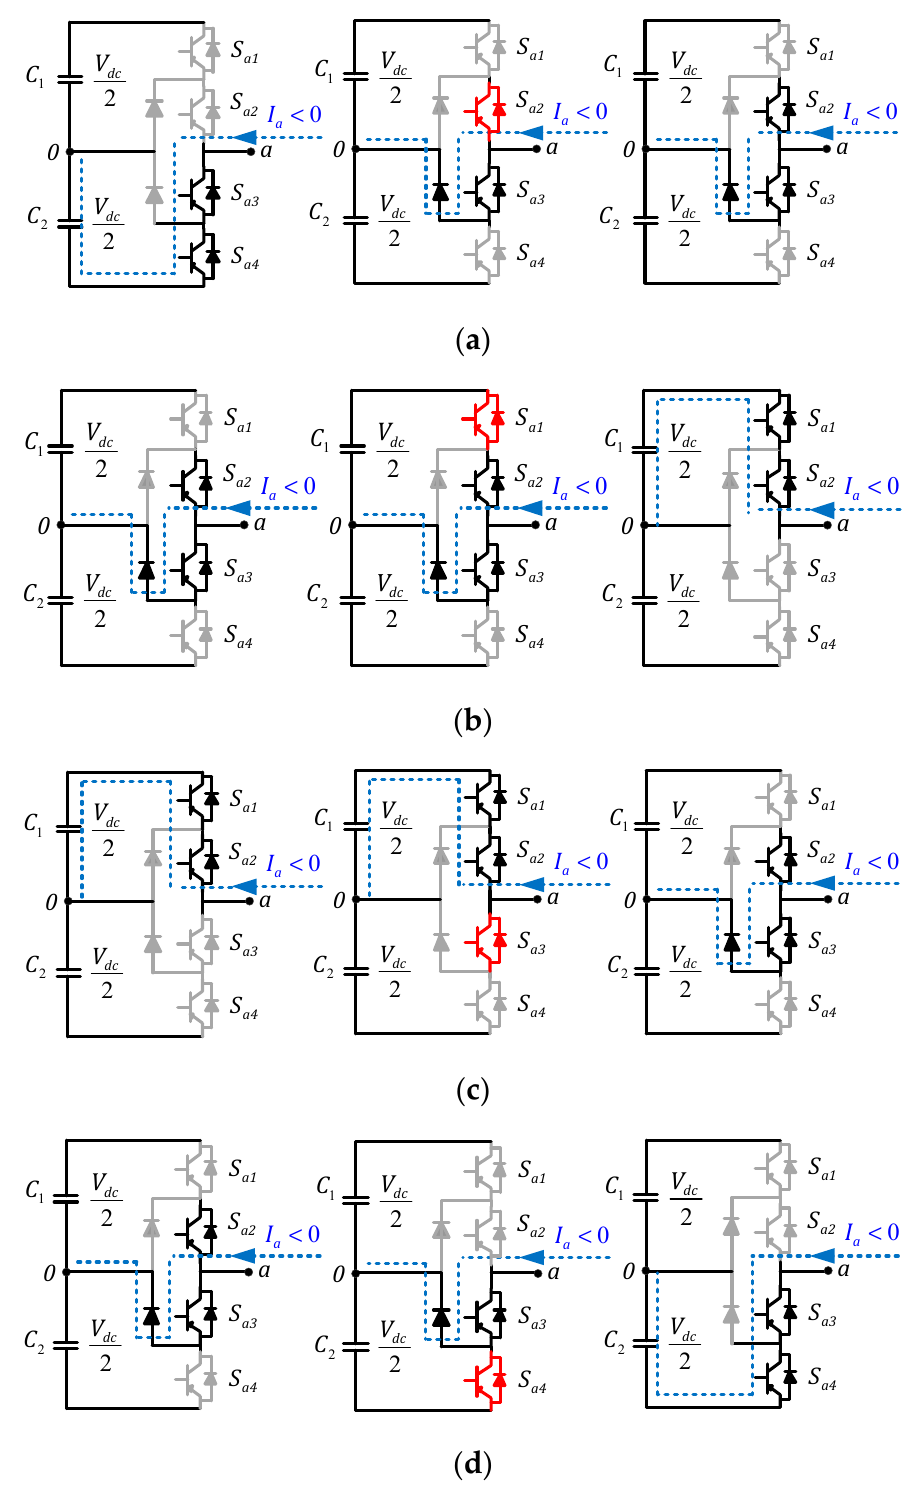
Figure 11. Transient state of switching at negative current: ( a ) From -Vdc/2 to 0; ( b ) from 0 to +Vdc/2; ( c ) from +Vdc/2 to 0; ( d ) from 0 to -Vdc/2 [2].